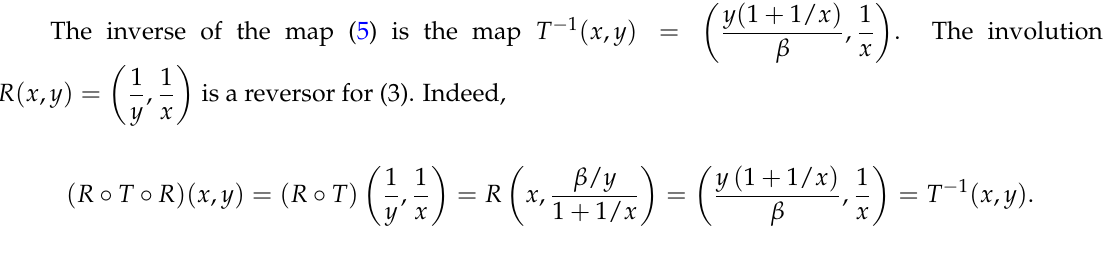
Figure 3. ( a ) The first twelve iterations of symmetry line S 0 of the map T for β = 0.18; ( b ) the first eleven iterations of symmetry line S 1 of the map T for β = 0.18; ( c ) the periodic orbits of period 22 (red) and 18